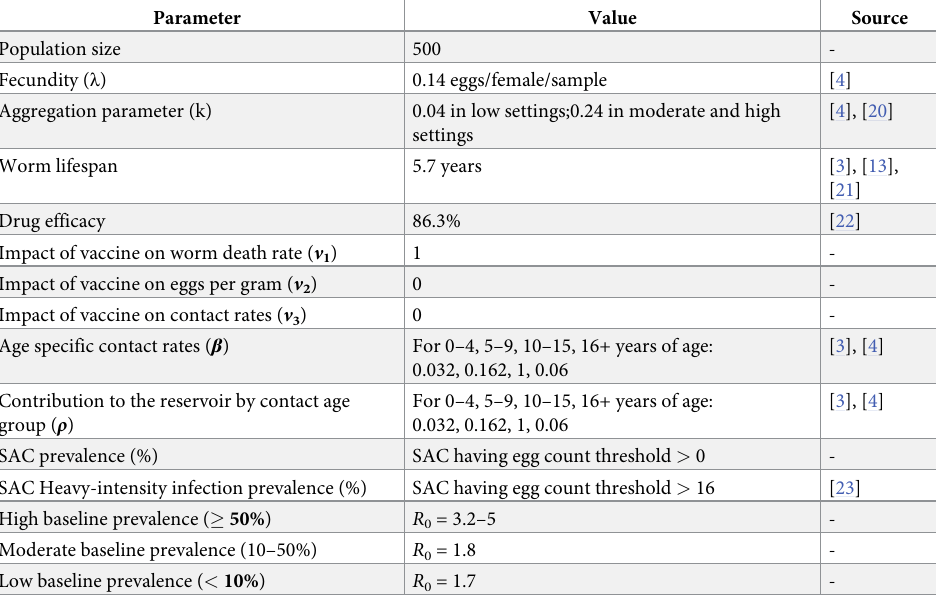
Table 2. Parameter definition and age specific contact rates for S . mansoni in Iietune, Kenya [3],